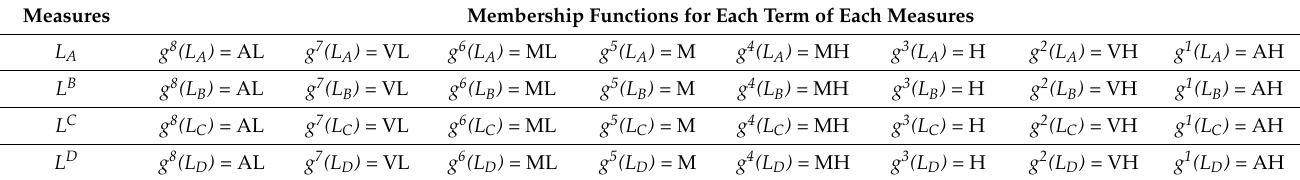
Table 2. The membership functions.